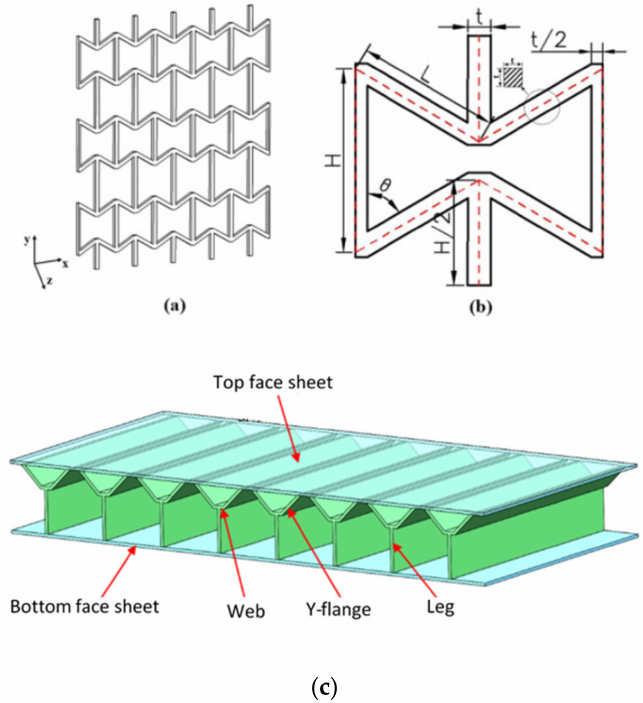
Figure 6. ( a ) 2D representation of auxetic cellular structure; ( b ) Representative unit cell [49]; ( c ) Y-shaped core